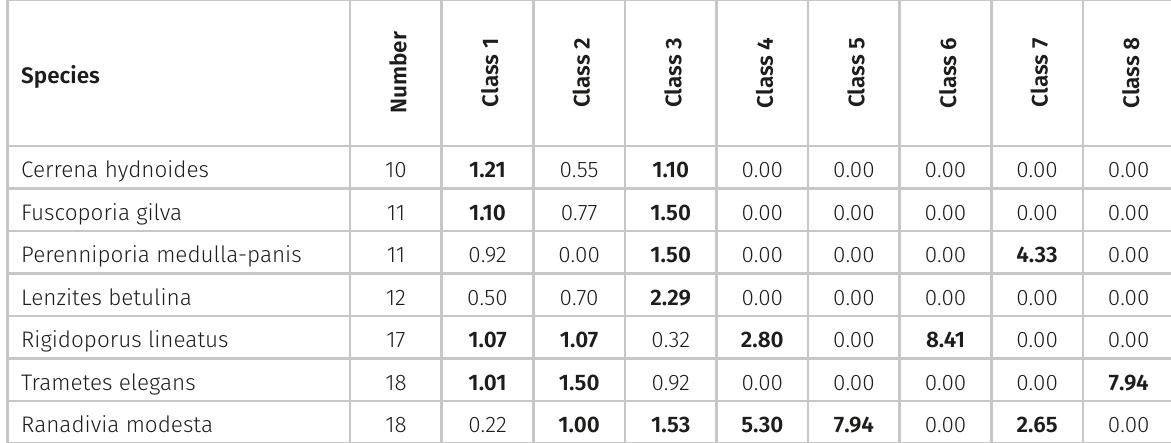
Table VII. Substrate utilization index ( U ) by class of Hymenochaetales and Polyporales substrate diameter with i more than ten records at Silvio Braga HPP, Santarém, PA. Values in bold significant to preference.